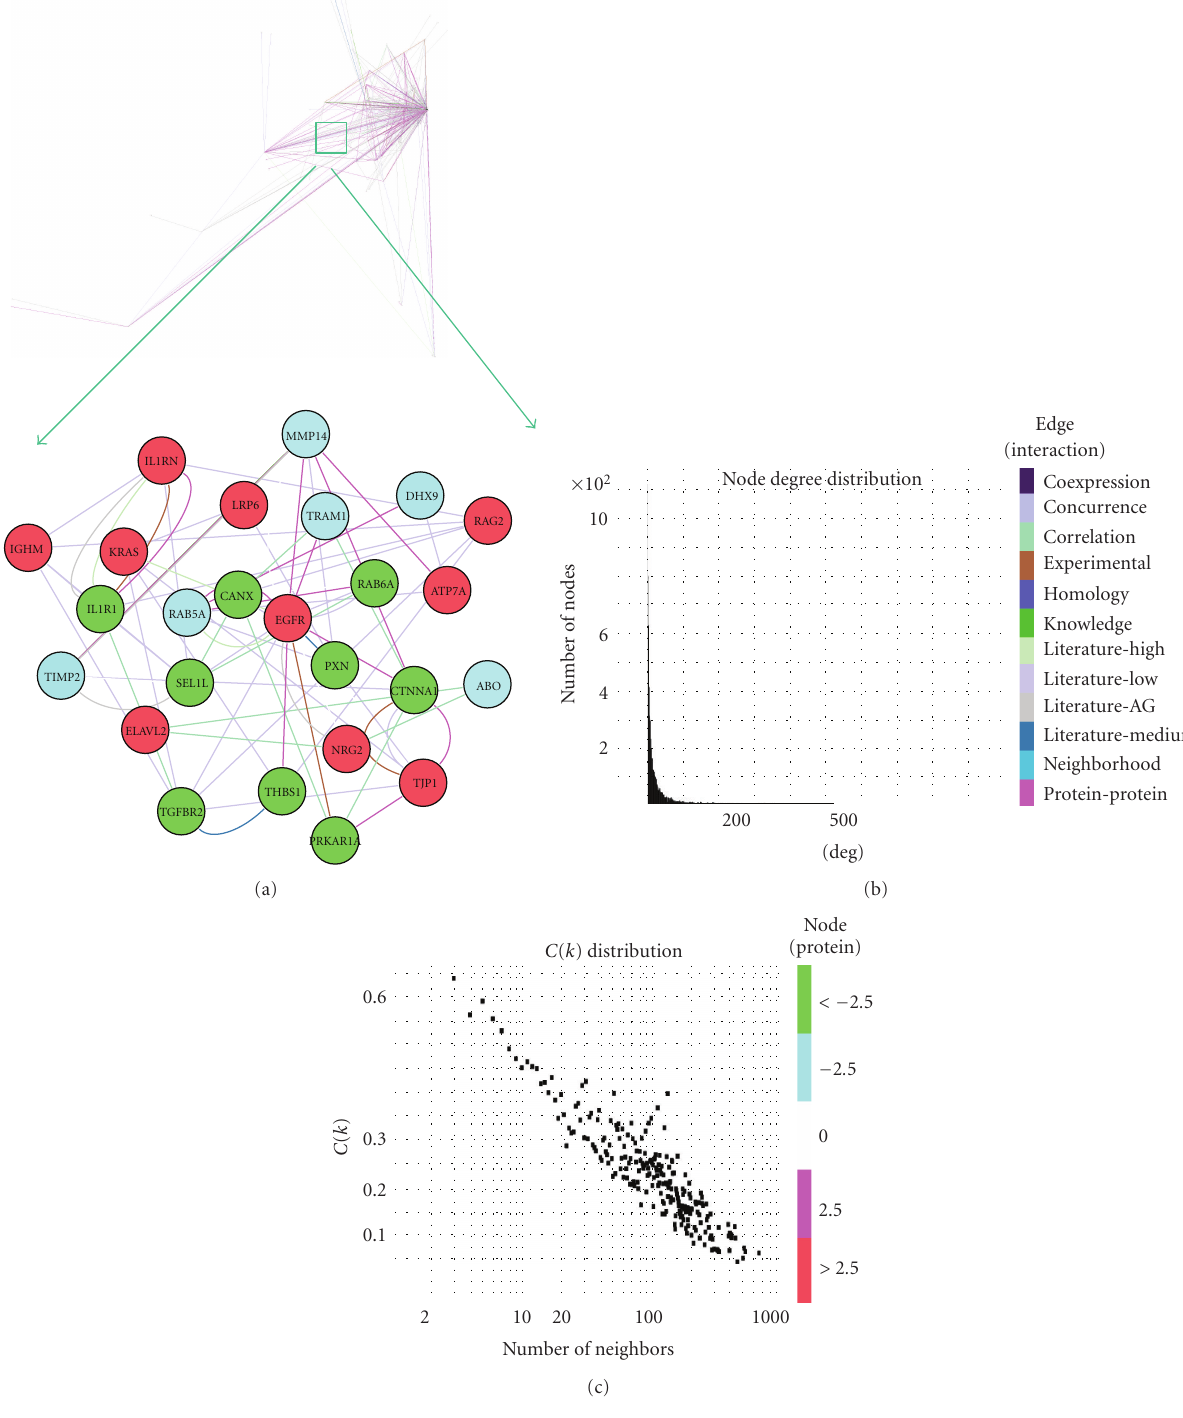
Figure 1: A comprehensive regulatory network linked to HCMV entry. The network was constructed by using protein-protein binding database and protein functional database (see text and Section 4 for details). The insert shows a zoomed portion of entire network. The colors of nodes (proteins) and edges (interactions) represent gene expression levels (red color-upregulation, green color-downregulation compared with mock-control) and edge sources, respectively. The same color strategy for nodes and edges will be used for all figures in this study unless otherwise specified. Also shown are entire network properties, including node degree distribution that approximates a power law, P ( k ) ∼ k − γ ( γ = 0 . 95 in our network), and C ( k ) distribution, average clustering coe ffi cient that measures the tendency of nodes to form clusters, which decreases with the number of